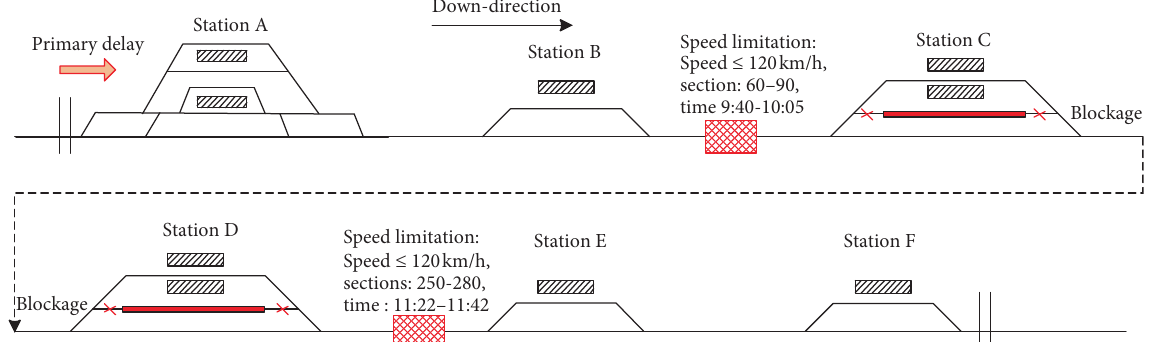
Figure 8: Parameters of railway infrastructure and disturbances.